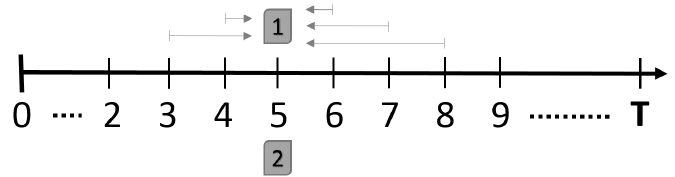
Figure 5. Demonstration of the entire simulation setup for each time slice using a single scheme. The example above interpolates Time Index 5, using scheme (2, 3). Map 1 (top) is the “estimated” map generated using the STI method; Map 2 (bottom) is the “observed” map based on the original data. The objective performance of the algorithm is measured using